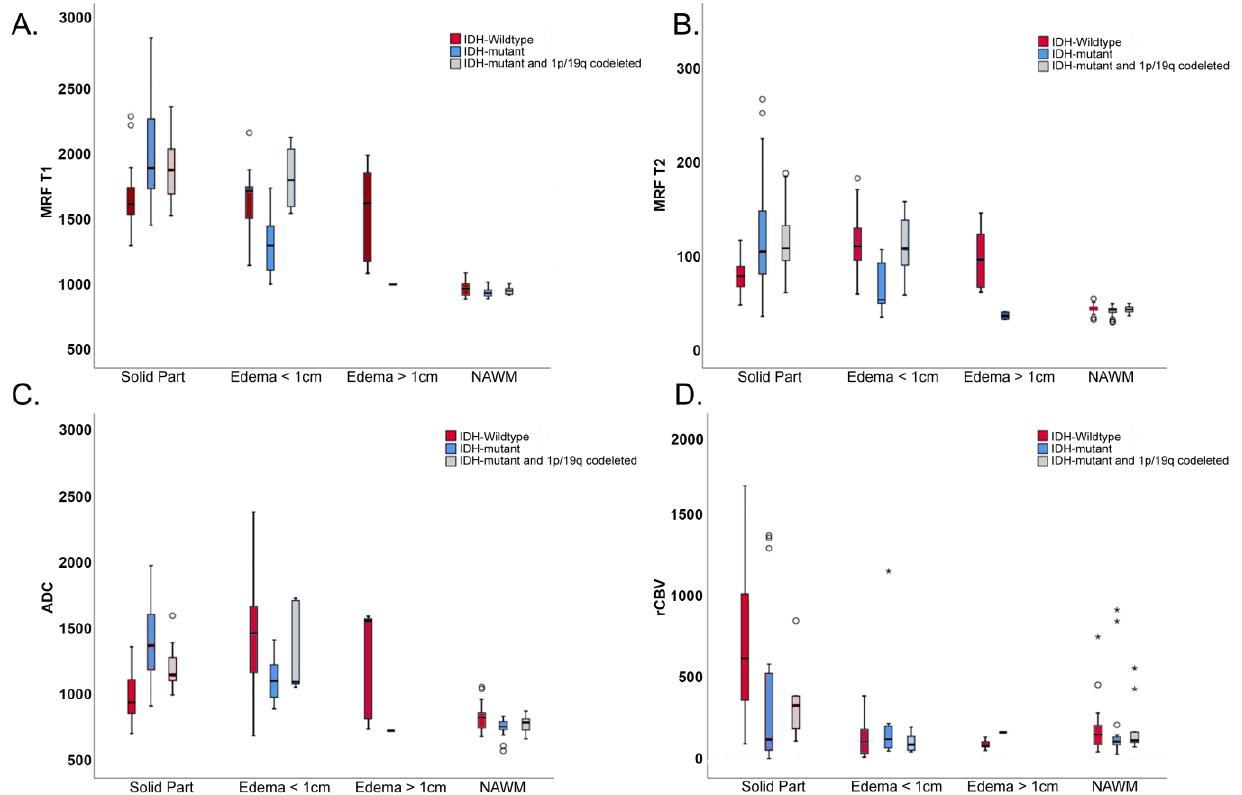
Figure 3. MRF T1 ( A ) and T2 relaxation time values ( B ), ADC values ( C ), and rCBV values ( D ) from different types of tissue (solid part of the tumor, peritumoral edema ≤ 1 cm distant from the tumor and >1 cm distant from the tumor, and NAWM) in IDH-wildtype, IDH-mutant, and IDH-mutant and 1p/19q codeleted diffuse gliomas. Please note the significant difference in MRF T1, MRF T2, and ADC in solid tumor parts between the IDH-mutant and IDH-wildtype. Also note the significant difference in MRF T1 and T2 in peritumoral edema ( ≤ 1 cm distant from the solid part) between IDH-mutant and IDH-wildtype.